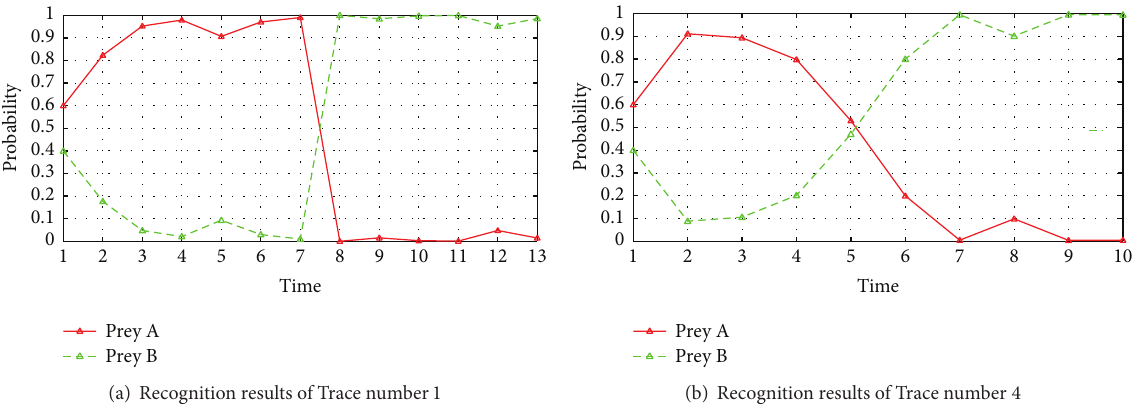
Figure 3: Recognition results of two specific traces computed by the Dec-POMDM and MF.